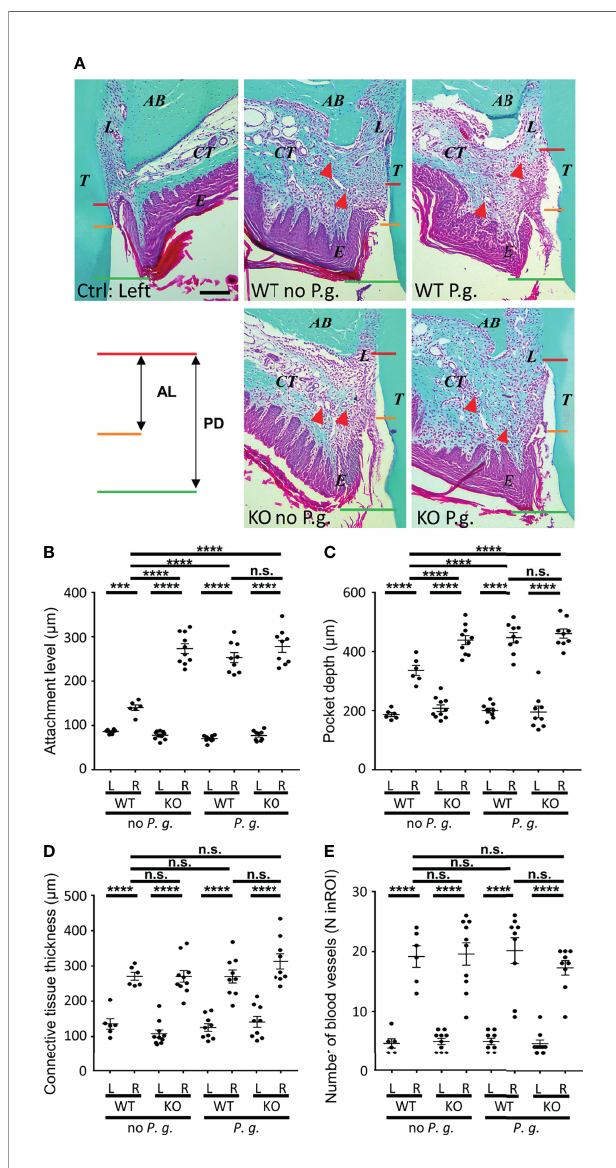
FIGURE 2 | Histological characteristics of periodontal region after periodontitis induction. (A) Representative images of Masson Trichrome- stained sections of periodontitis side (right panels) and control side (individual left panel) at 10X objective lens magni fi cation. (T, tooth, fi rst palatine molar; L, periodontal ligament; AB, alveolar bone; CT, connective tissue; E, epithelium; the red triangular indicates the blood vessel). The measurements of pocket depth (PD, between red line and green line) and the attachment level (AL, between red line and yellow line) are shown. Scale bar = 200 m m. (B) The attachment level (AL) is the distance measured from cemento-enamel junction ( A , yellow lines) to the bottom of the periodontal pocket ( A , red lines). (C) The pocket depth (PD) is the measured distance from the gingival margin ( A , green lines) to the bottom of the sulcus ( A , red lines). (D) The connective tissues thickness was measured from the alveolar bone crest to the base of epithelium. (E) The blood vessels were counted in a standardized region of interest (ROI) of the connective tissue (ROI = 0.23 mm 2 ). (B – E) Each dot represents the measurement obtained from a single mouse. Horizontal bars represent the mean +/- SEM. Ordinary one-way ANOVA followed by uncorrected Fisher ’ s LSD, with a single pooled variance multiple comparison test. ***P < 0.001, ****P < 0.0001, n.s. P ≥ 0.05, non-signi fi